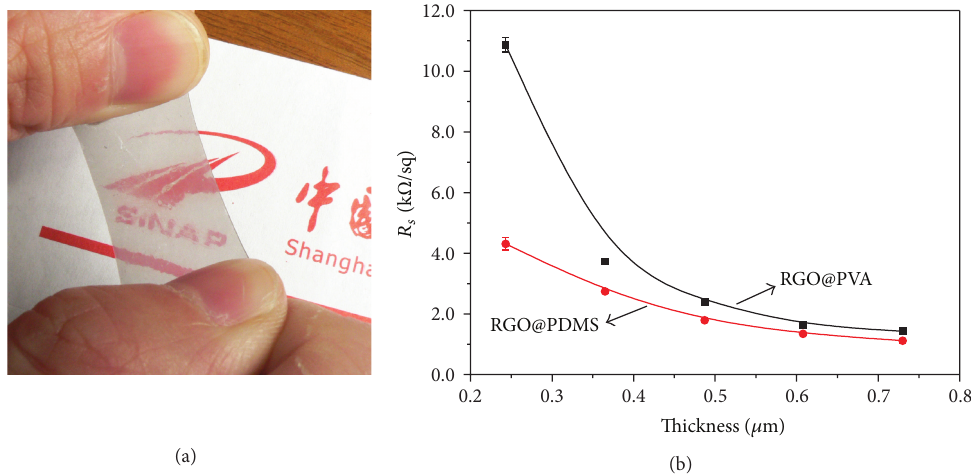
Figure 4: Photograph of (a) RGO@PDMS composite film, (b) the relationship of sheet resistances with the thickness of RGO layer of the composite films.